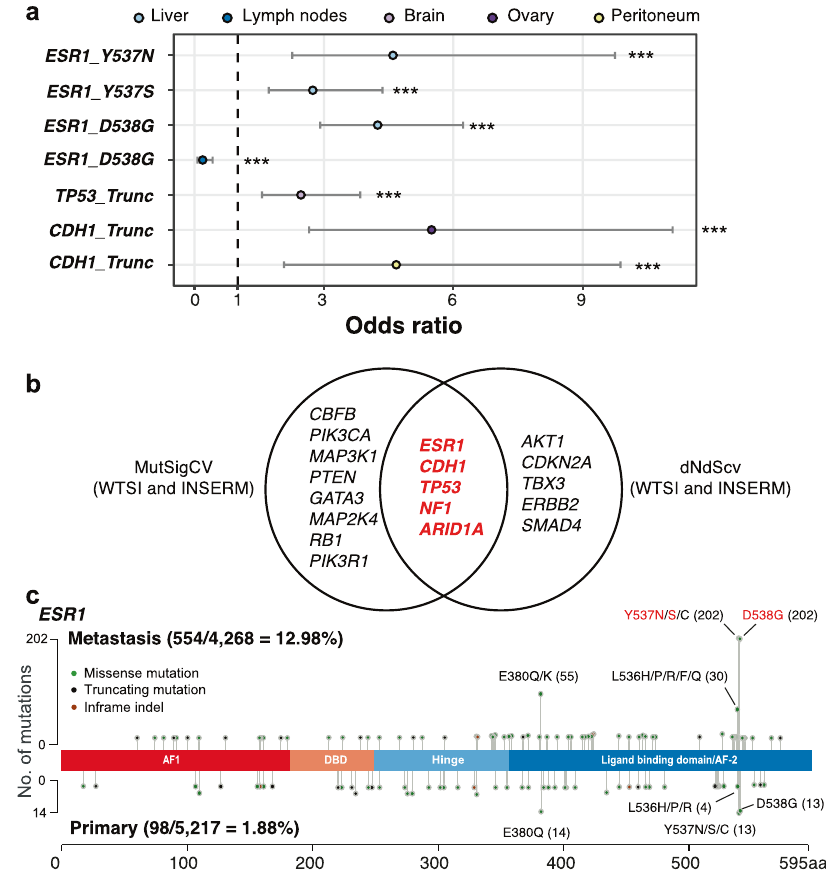
Fig. 4 Suggestive driver mutations according to metastatic sites. a Signi fi cant MBC driver mutations across metastatic sites are shown by comparing 27 candidate driver mutations from MBC of a speci fi c metastatic site with other metastatic sites or PBC. Presented results are from the logistic regression analysis for mutational frequency of 27 candidate driver mutations between MBC samples from different metastatic sites. Truncating mutations are represented by “ Trunc ” and missense mutations are shown by their amino acid change. Odds ratios and 95% CI for each mutation were shown and asterisks indicate statistical signi fi cance at FDR < 0.01. b MBC driver genes of WTSI and INSERM cohort data which had suf fi cient background mutations from the results of MutSigCV and dNdScv. c Mutation types of ESR1 shown in a lollipop plot. Red-colored variants are candidate driver mutations enriched in MBC samples. X -axis indicates amino acid